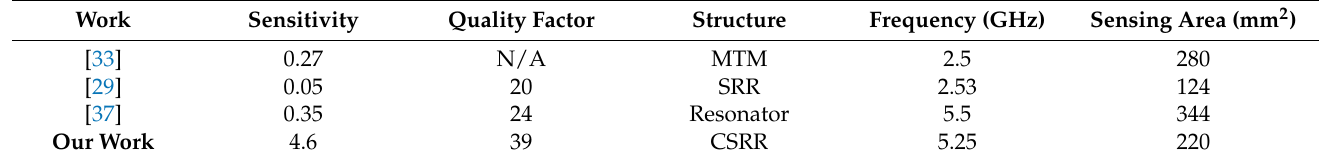
Table 5. Comparison of proposed sensor and other